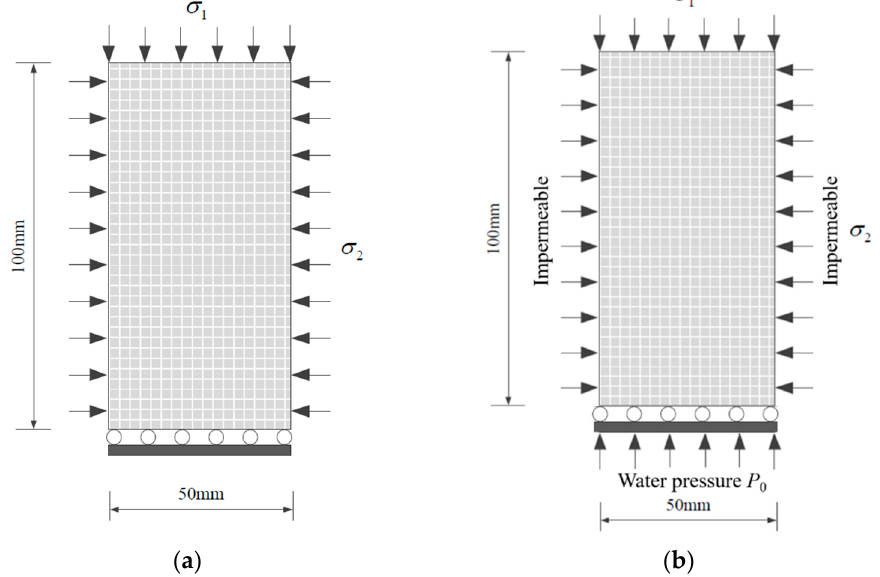
Figure 4. Numerical calculation model: ( a ) Conventional triaxial model, ( b ) Hydro-mechanical coupling model.